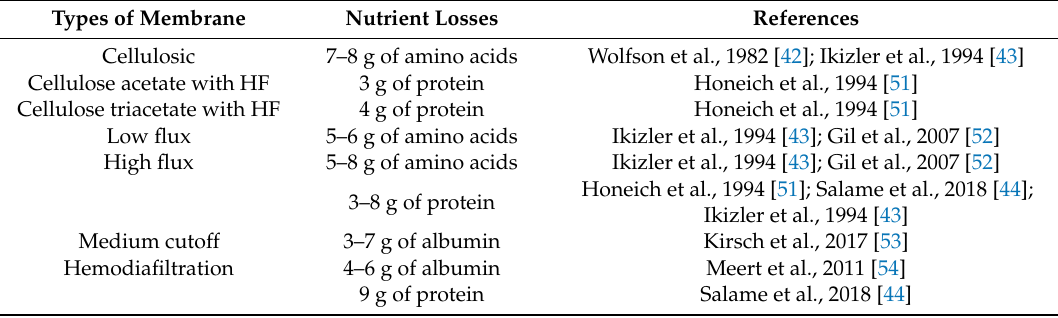
Table 3. Protein and amino-acid losses according to types of dialyzer